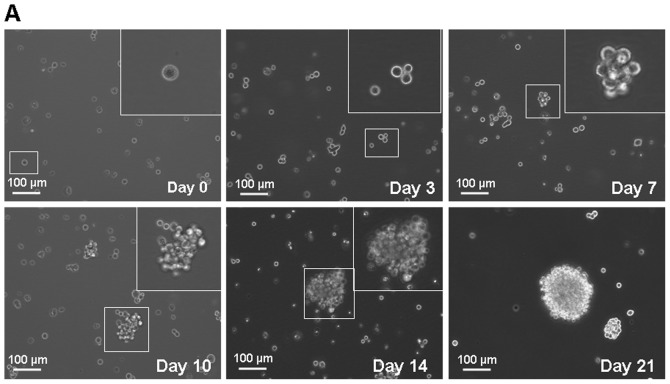
MKN-45 cells formed the anchorage-independent, self-renewing spheroid bodies. (A) Generation of a spheroid body from a single MKN-45 cell. The propagation of a single cell cultured in a 96-well dish was recorded at day 0, 3, 7, 10, 14 and 21, separately (×200 magnification). (B) The sub-spheroid body formation rate of spheroid body cells were also higher than that of parental cells (*p<0.01).